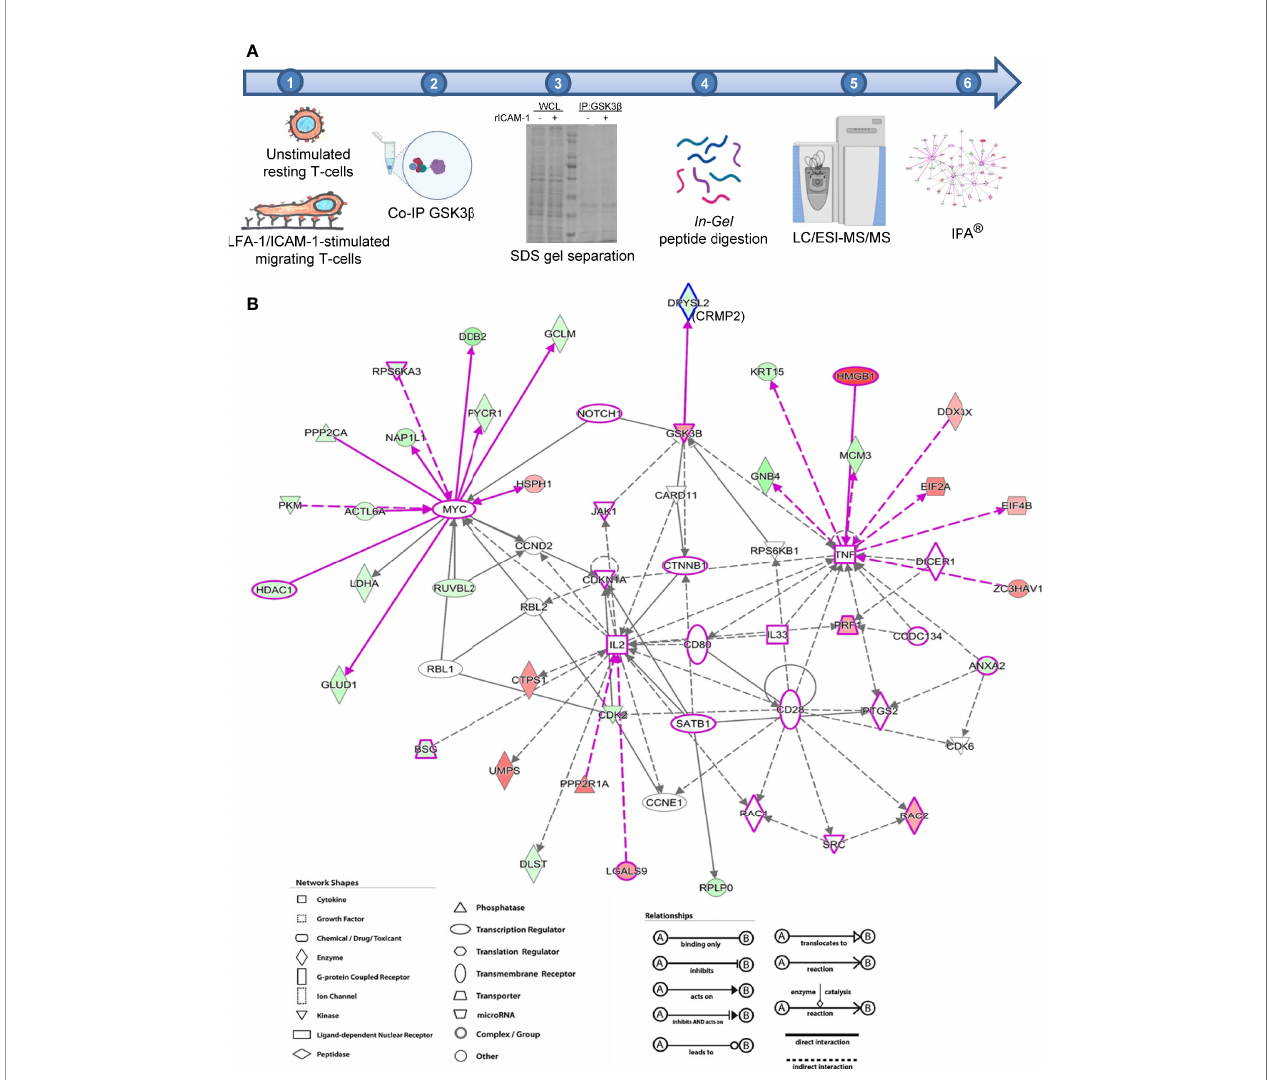
FIGURE 2 | Identi fi cation of GSK3 b interactome in migrating T-cells. (A) Schematic representation of work fl ow employed in mass spectrometry-based proteomics analysis of GSK3 b interacting proteins in human HuT78 T-cells. (B) Image output from IPA Ingenuity Knowledge Base indicating statistically probable interactions of GSK3 b in LFA-1-stimulated T-cells. Proteins depicted in red are high abundance in migrating T-cells and proteins shown in green are low in abundance, compared to resting T-cells. The protein symbols in purple highlight proteins curated from Ingenuity Knowledge Base with potential roles in cellular movement and modelled relationships among known functional networks in immune cells. The type of proteins, network, shapes, and relationships in IPA are provided in the